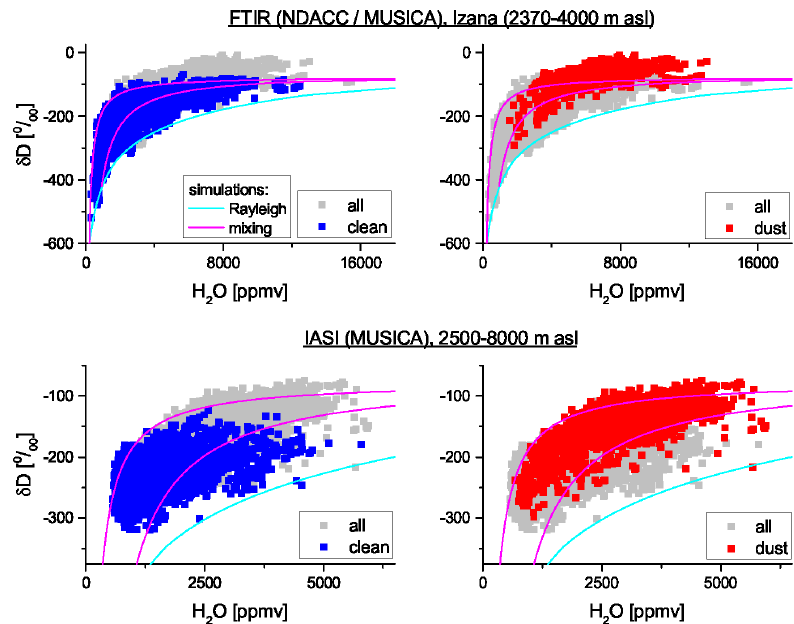
Figure 15. As Fig. 14, but for MUSICA’s remote sensing observations between 2005 and 2014.